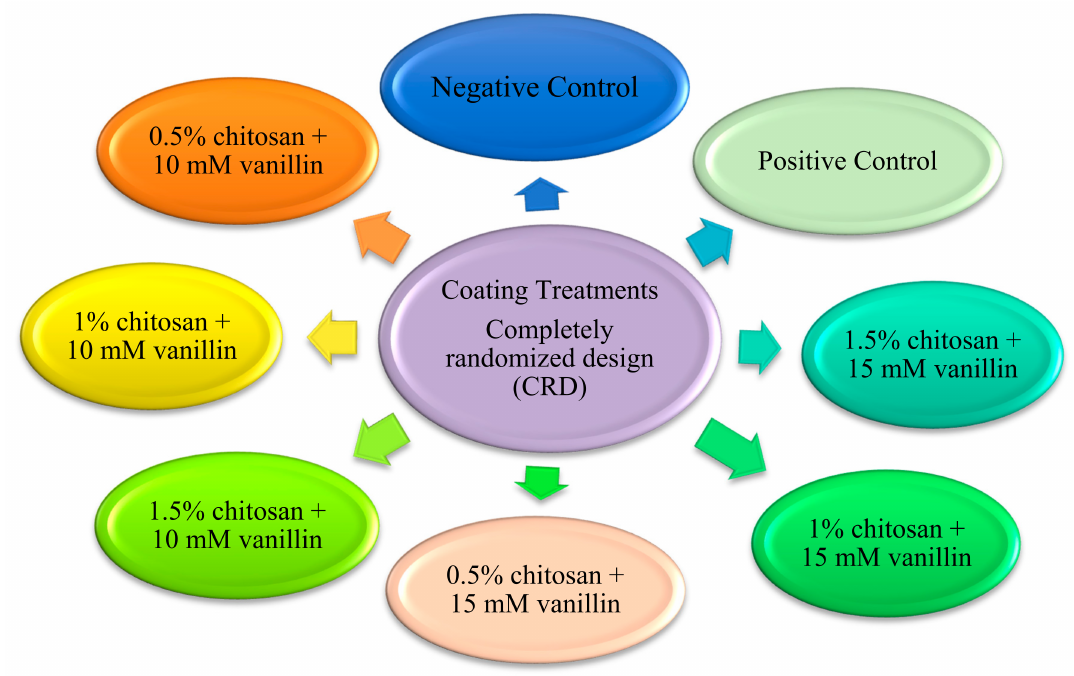
Figure 2. Schematic diagram of eight coating treatments used for Fusarium oxysporum inoculated tomato fruit stored for 15 days at 26 ± 2 ◦ C and 60 ± 5% relative